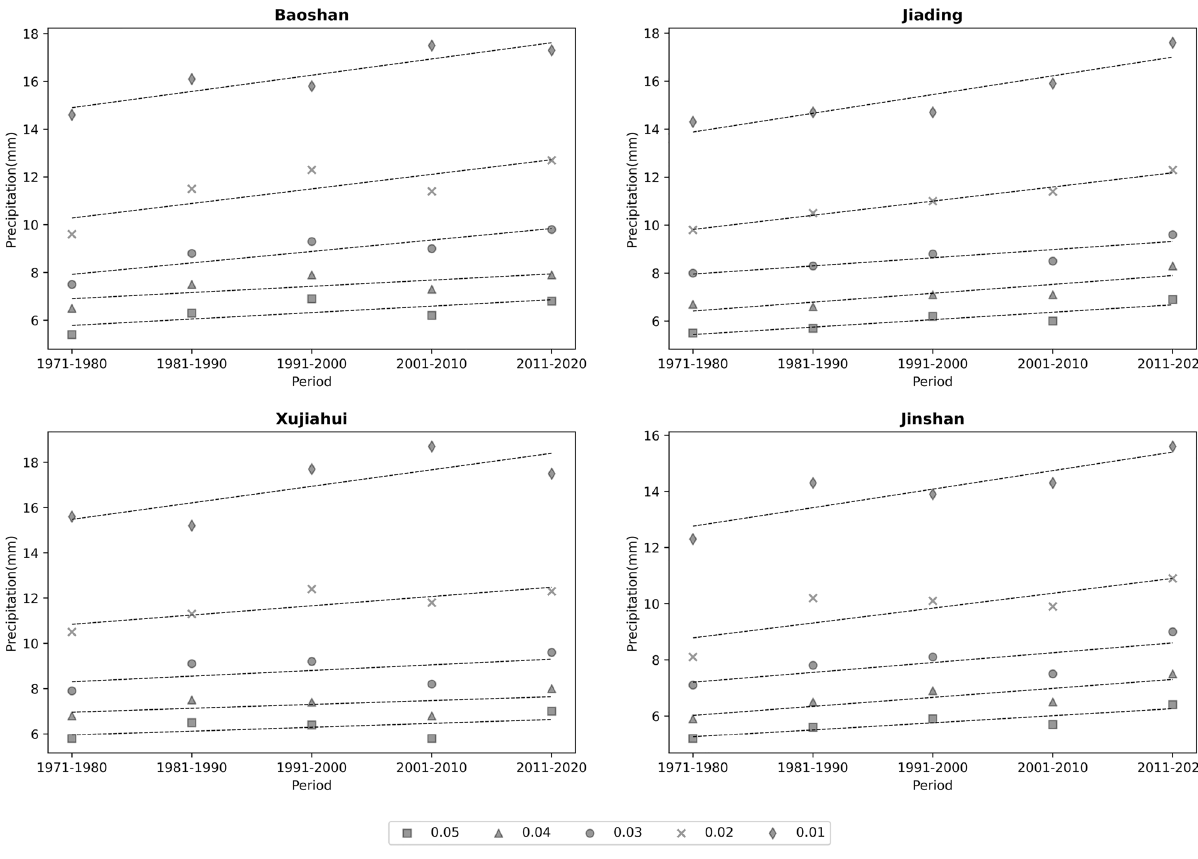
Figure 6. Variation of precipitation at different precipitation probabilities in each period.